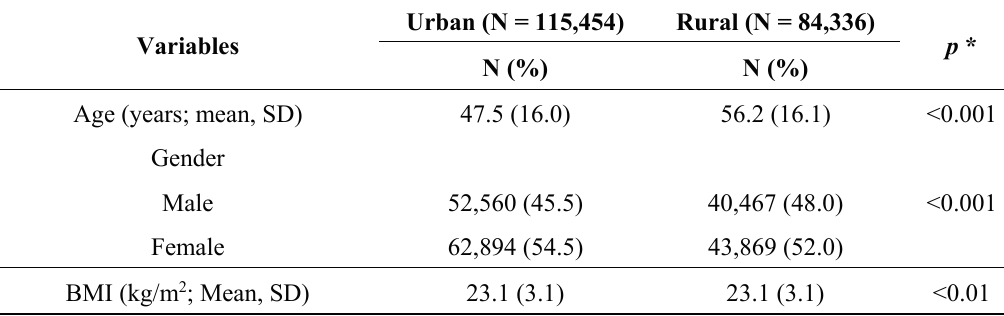
Table 1. Sociodemographic characteristics of the study population according to